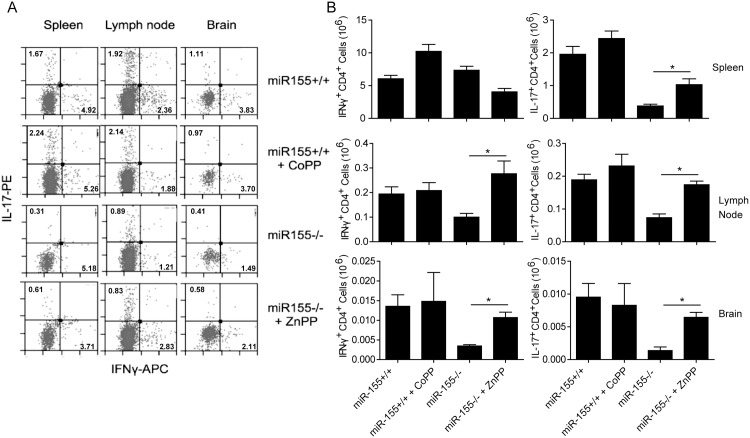
Th1 and Th17 responses in the spleen, LN or brain of miR-155
+/+ and miR-155
-/- treat with CoPP or ZnPP after MOG35-55-immunization.(A) Flow cytometric analysis of IFN-γ and IL-17 expression in T cells (Gated on CD3 and CD4 double positive cells) from spleen, LN and brain of miR-155
+/+ or miR-155
-/- mice immunized with MOG35-55 and treated or not treated with CoPP or ZnPP. Data are shown as mean ±SEM. n = 6 mice per group. The results are representative of two independent experiments. (B) Numbers of IFN-γ- or IL-17-producing T cell (Gated on CD3 and CD4 double positive cells) from spleen, LN and brain of miR-155
+/+ or miR-155
-/-mice immunized with MOG35-55 and treated or not treated with CoPP or ZnPP. *: p<0.05. Data are shown as mean ±SEM. n = 6 mice per group. The results are representative of two independent experiments.